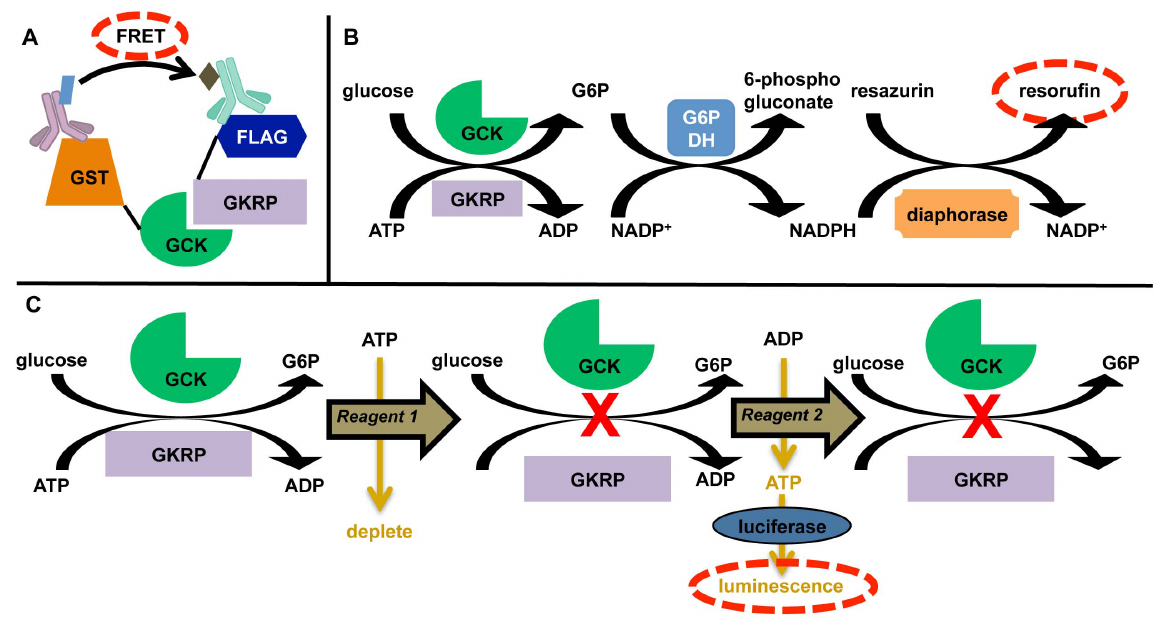
Figure 1. Parallel assay development strategy to interrogate recombinant GCK and GKRP. Human GCK and GKRP were affinity-purified using GST and FLAG tags, respectively. (A) FRET-based (HTRF) detection. Antibodies recognizing the affinity tags are conjugated to FRET donor and acceptor molecules. Excitation of the donor results in energy transfer (FRET; red dashed oval) to the acceptor only if the acceptor and donor are in close proximity. (B) Reaction scheme for G6PDH/diaphorase dual-coupled assay. The generation of the fluorescent product resorufin (red dashed oval) is measured as the reaction progresses in real time by excitation at 525 nm with emission at 590 nm. (C) Reaction scheme for coupling of ADP generation by GCK to luminescence-based detection. The GCK reaction is allowed to run for a set period of time, and the reaction is then terminated and a two-step reaction utilizes Ultra-Glo TM firefly luciferase to generate bioluminescence (red dashed oval). Reagent 1: ADP-Glo TM Reagent; Reagent 2: Kinase Detection